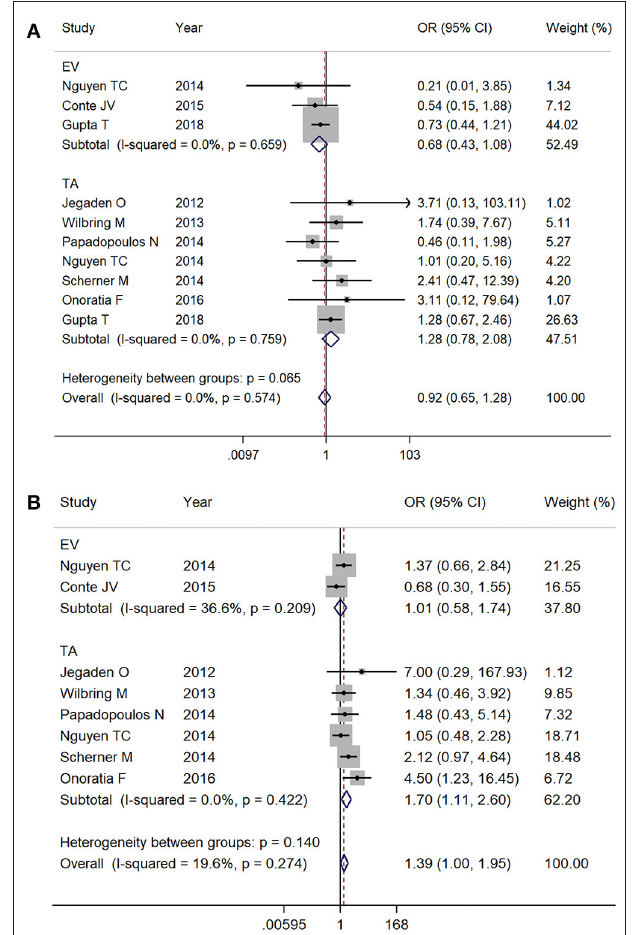
FIGURE 5 | Subgroup analysis by access: (A) 30-day mortality and (B) overall follow up mortality. EV, endovascular; TA,